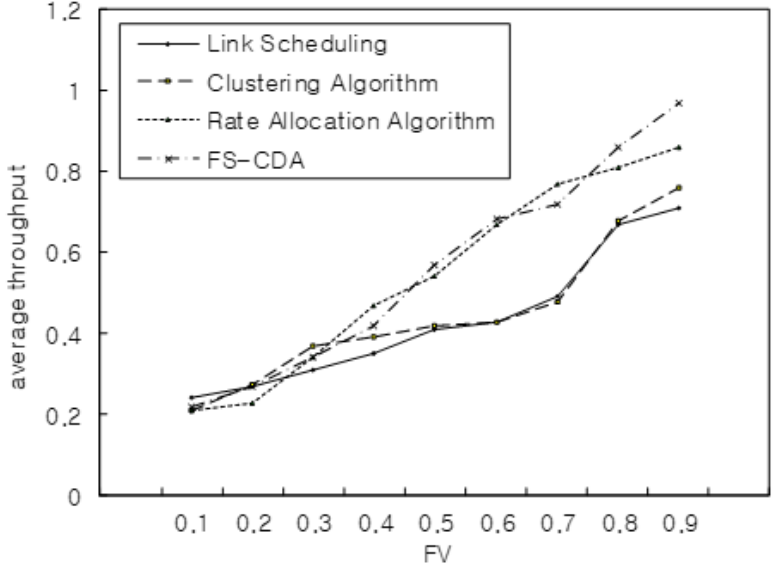
Figure 12. Average throughput with FV.